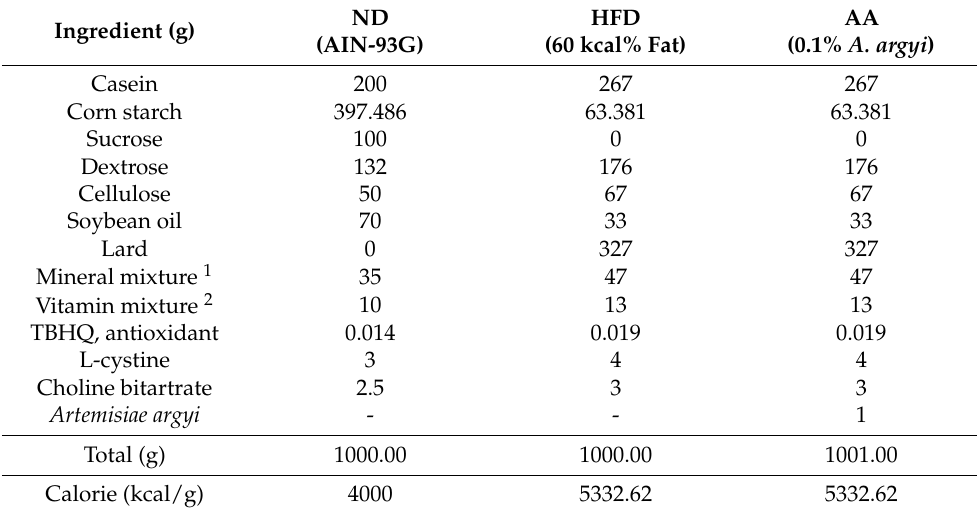
Table 2. Diet composition for animal